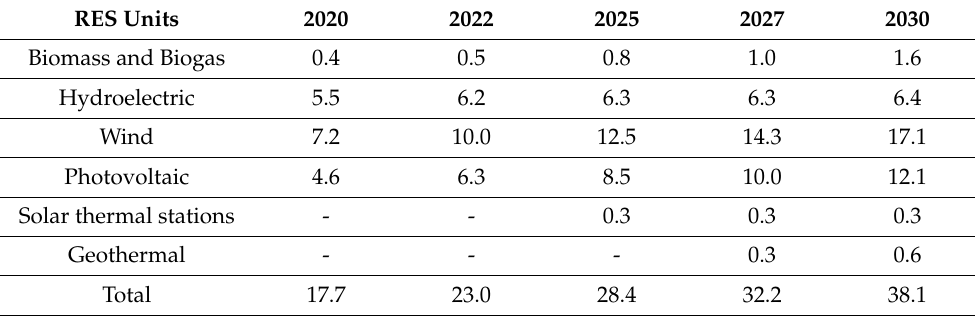
Table 2. Electricity generation from renewable energy sources units in TWh. RES